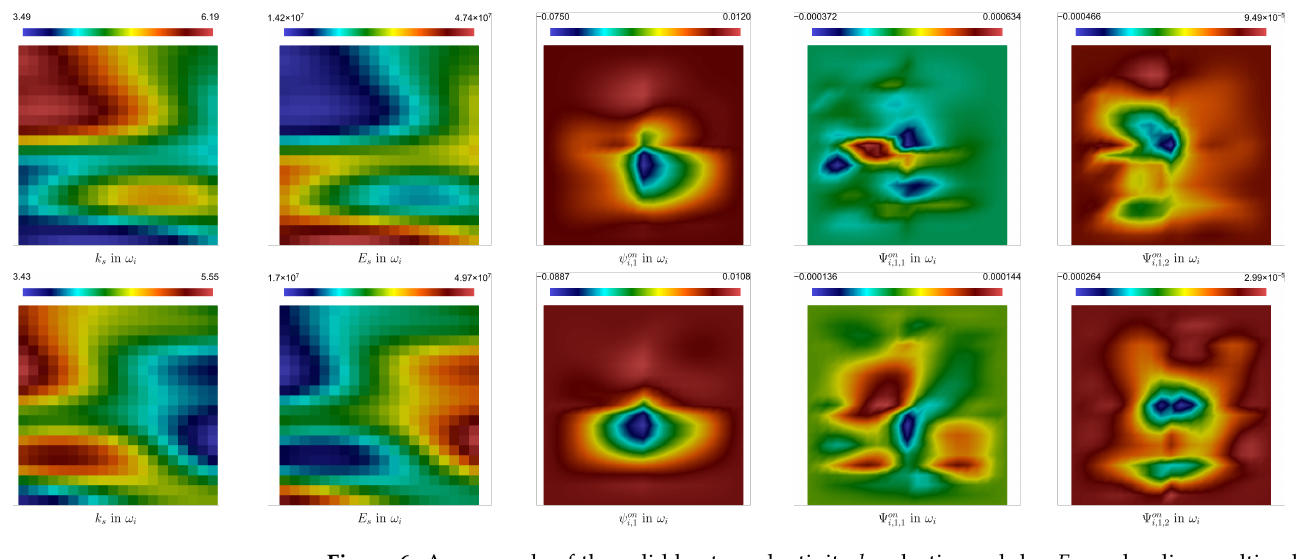
Figure 6. An example of the solid heat conductivity k s , elastic modulus E s , and online multiscale basis functions for temperature and displacements (from left to right) in two local domains (from top to